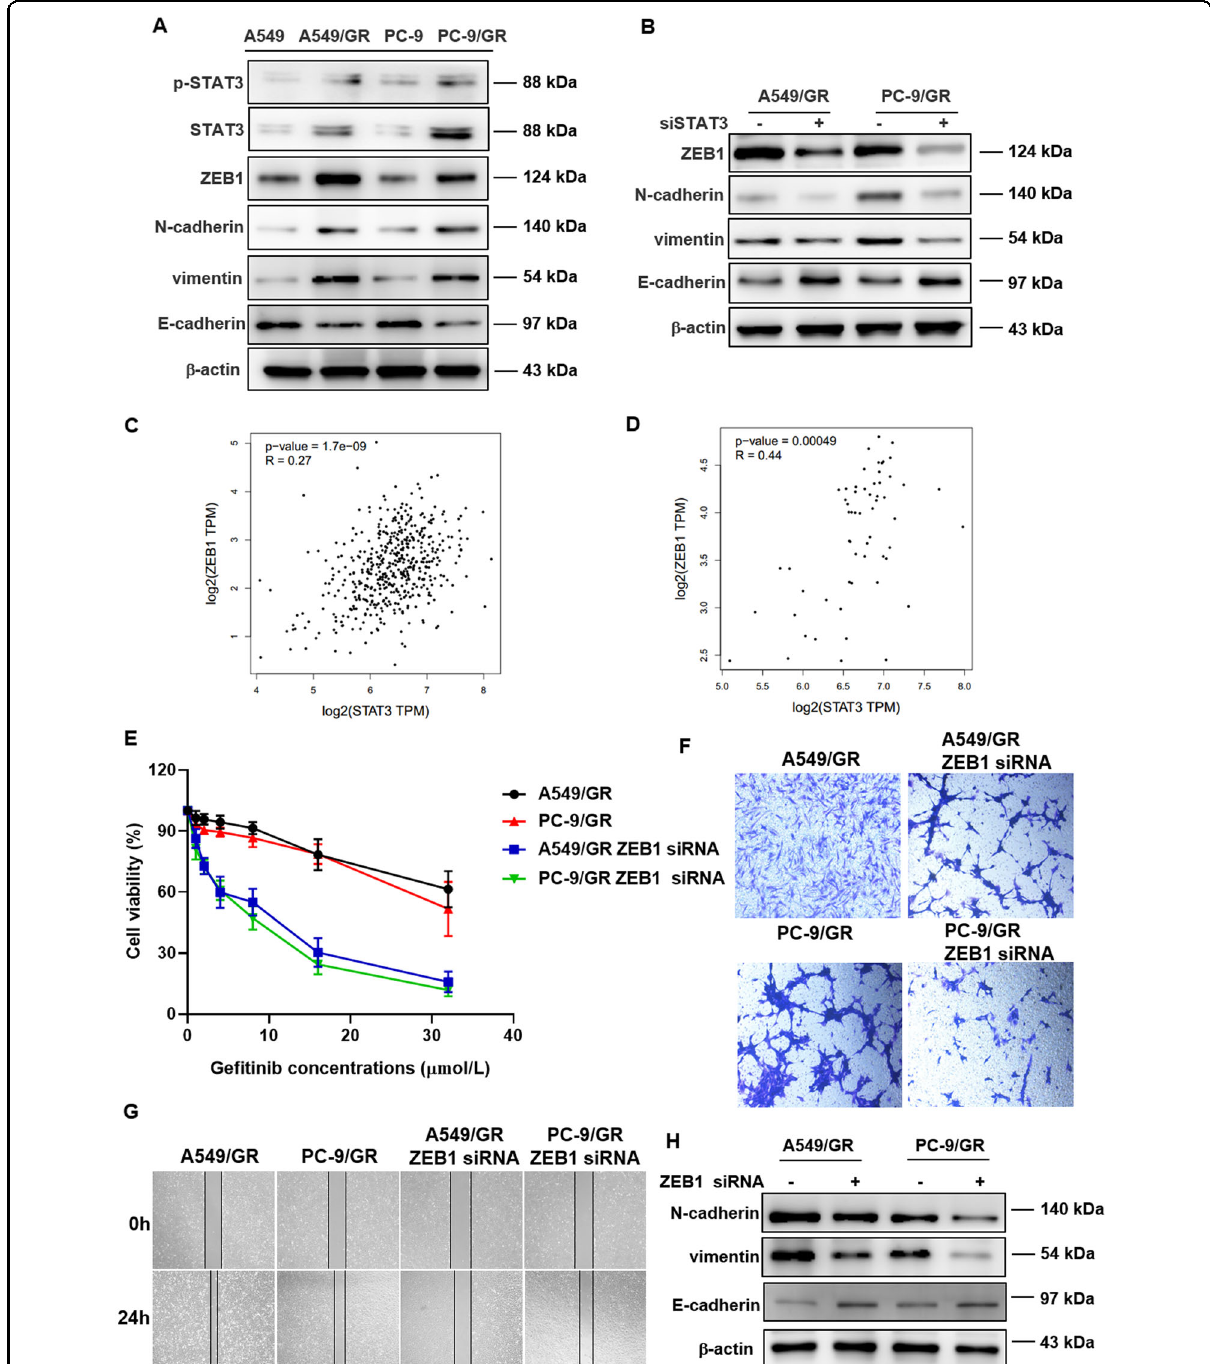
Fig. 3 Identi fi cation of ZEB1 as the mediator involved in the therapeutic effects conferred by STAT3 inhibition. A Protein levels of ZEB1, E- cadherin, vimentin, and N-cadherin were detected by western blot in A549, A549/GR, PC-9, and PC-9/GR cells. B STAT3 regulated the expression of ZEB1, E-cadherin, vimentin, and N-cadherin. The expression levels of the indicated proteins were examined by Western blot. C Correlation analysis between STAT3 and ZEB1 in tumor tissue. D Correlation analysis between STAT3 and ZEB1 in normal tissue. E Downregulation of ZEB1 increases the sensitivity of lung cancer cells to ge fi tinib. Cell viability was determined using the MTT assay. Downregulation of ZEB1 inhibits cell invasion ( F ) and migration ( G ). H ZEB1 regulated the expression of E-cadherin, vimentin, and N-cadherin. The expression levels of the indicated proteins were examined by Western